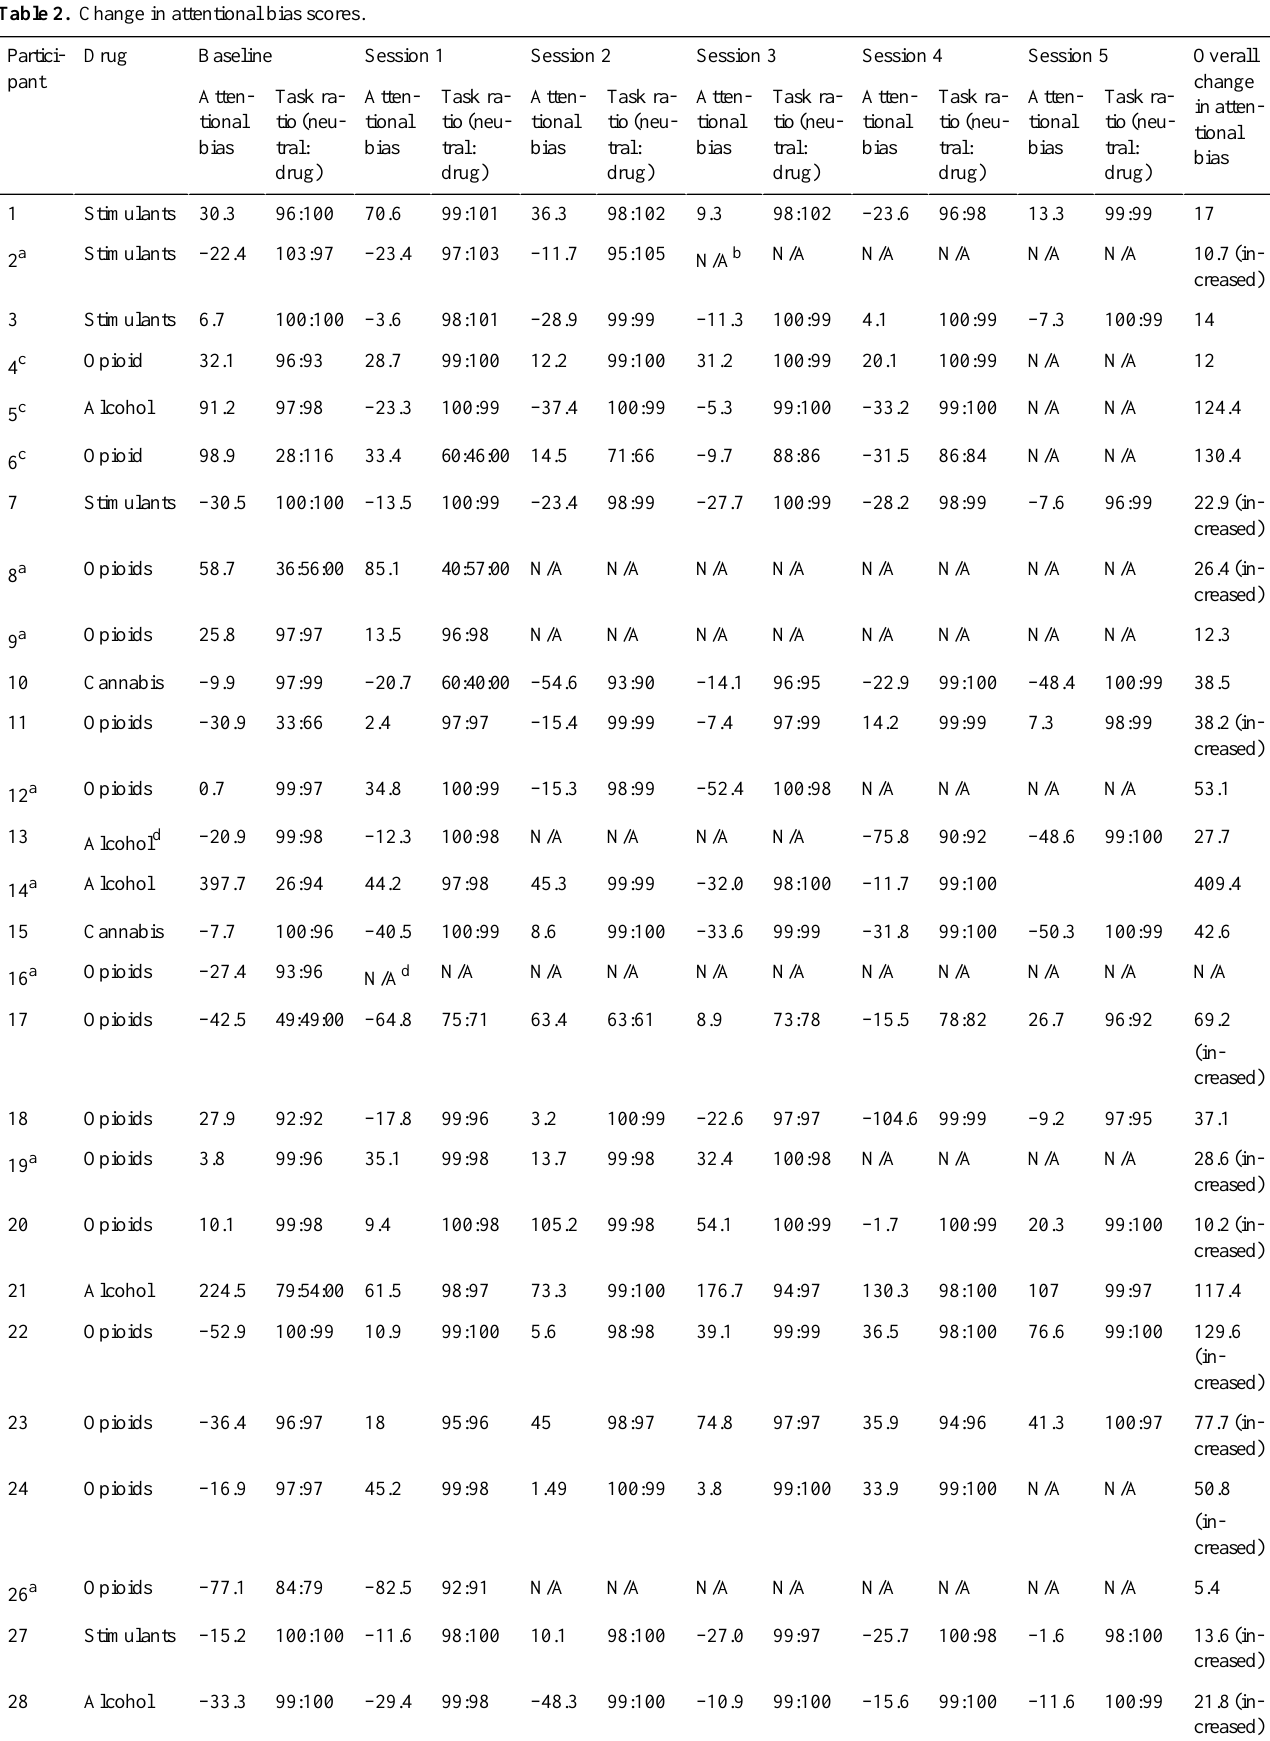
Table 2. Change in attentional bias